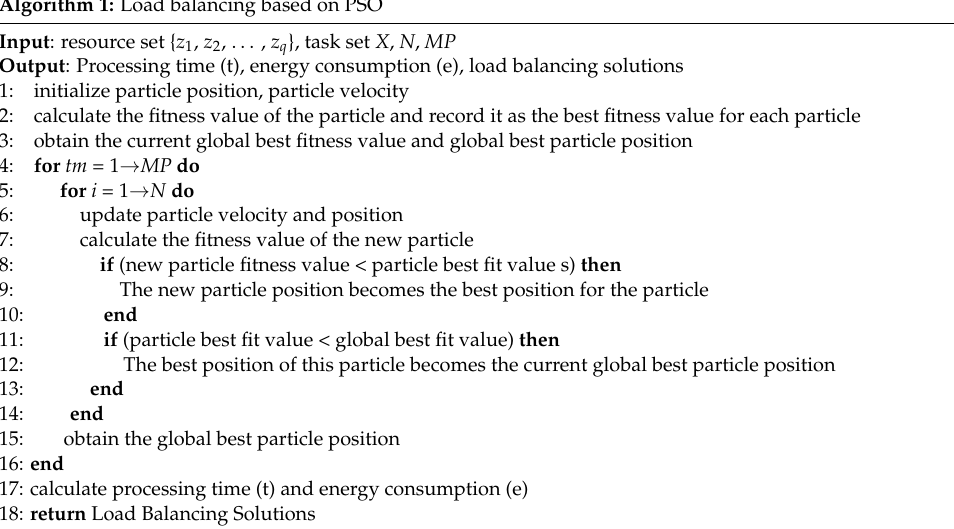
Algorithm 1: Load balancing based on